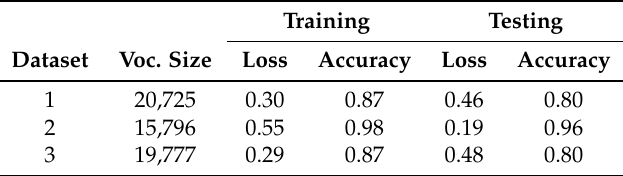
Table 7. Lexical Sequence—Word Embedding